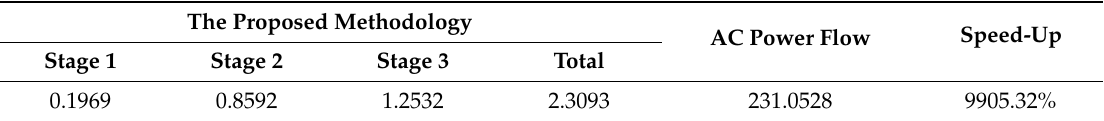
Table 6. CPU time required for the example